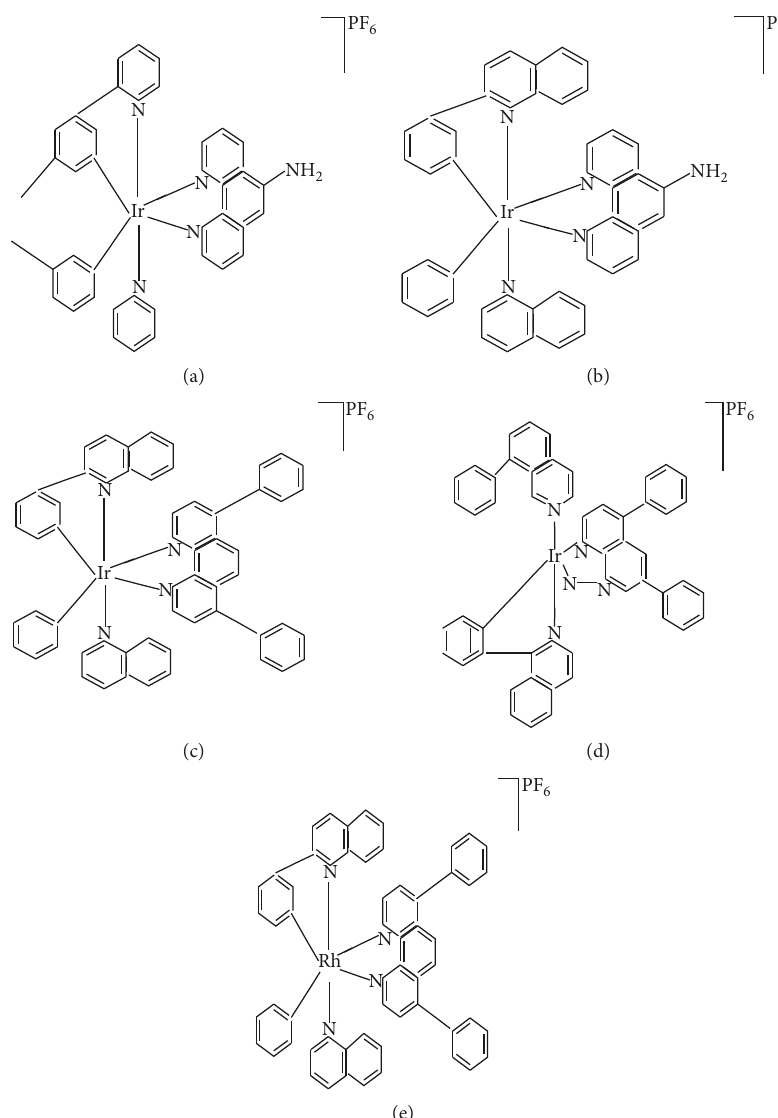
Figure 2: Molecular structure of cyclometalated iridium(III) complexes (a–d) and cyclometalated iridium(III) complex